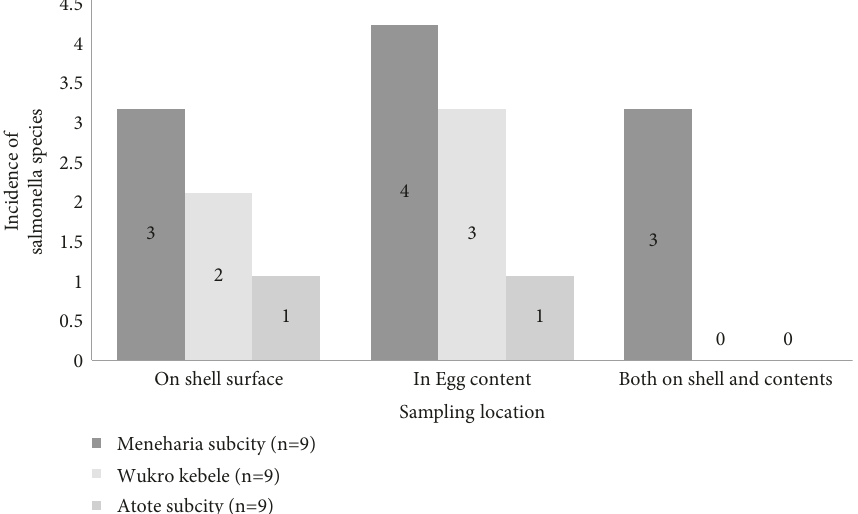
Figure 3: Incidence of Salmonella species in shell surface rinsates and contents of egg samples collected from markets in